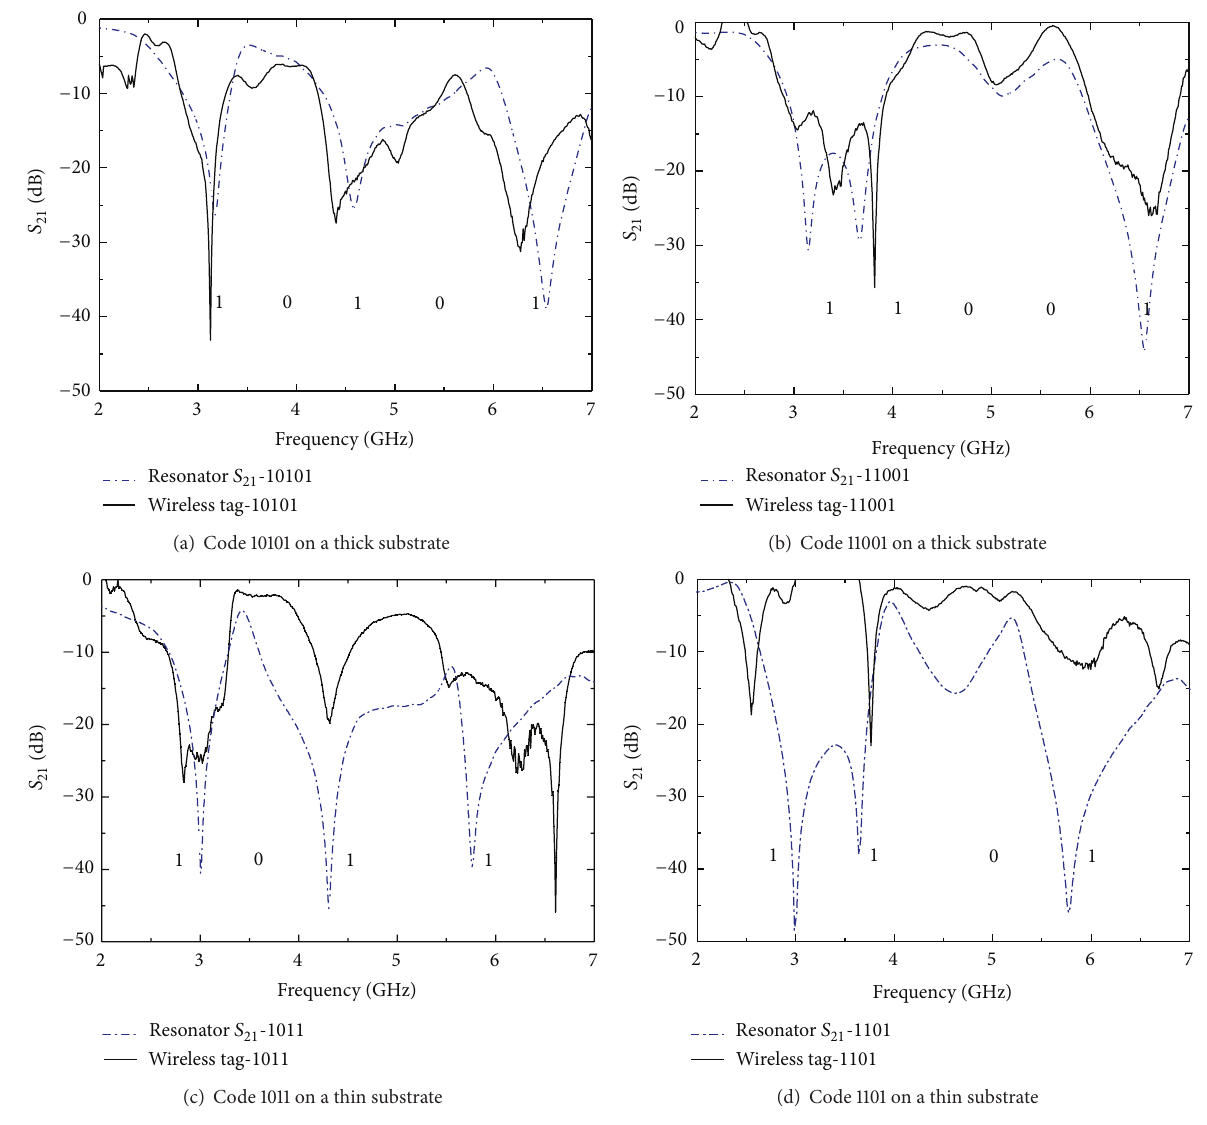
Figure 9: Measured results of the proposed microwave tag in wireless